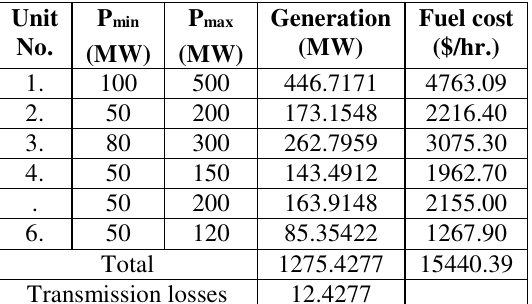
TABLE A1: OPTIMAL GENERATIONS FOR TEST CASE 2